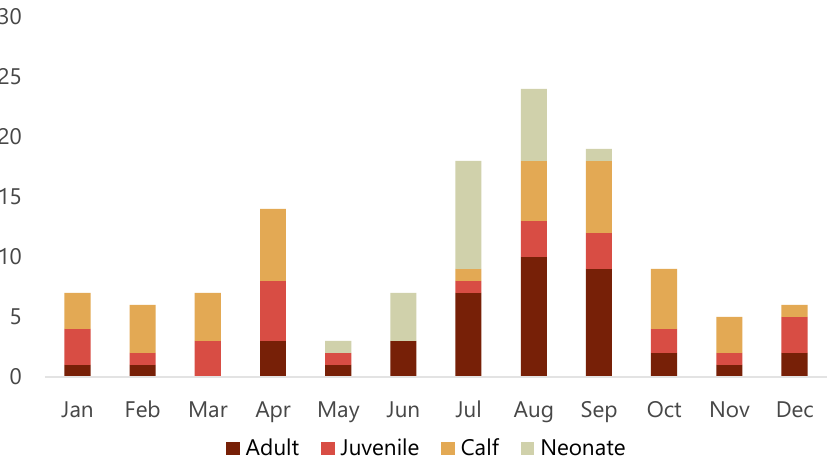
Figure 2. Number of harbour porpoises ( Phocoena phocoena ) that stranded per month along the Swedish coast from 2006 to 2020 and brought in for post-mortem examination.